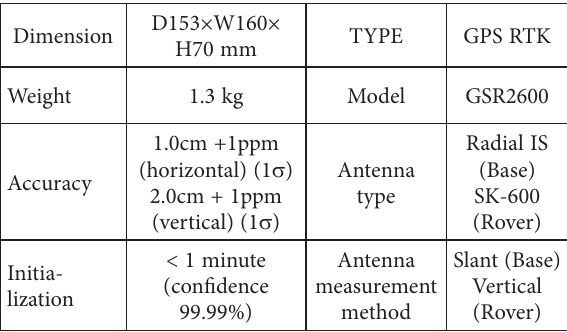
Table 4. Specifications for Sokkia GSR2600 GPS